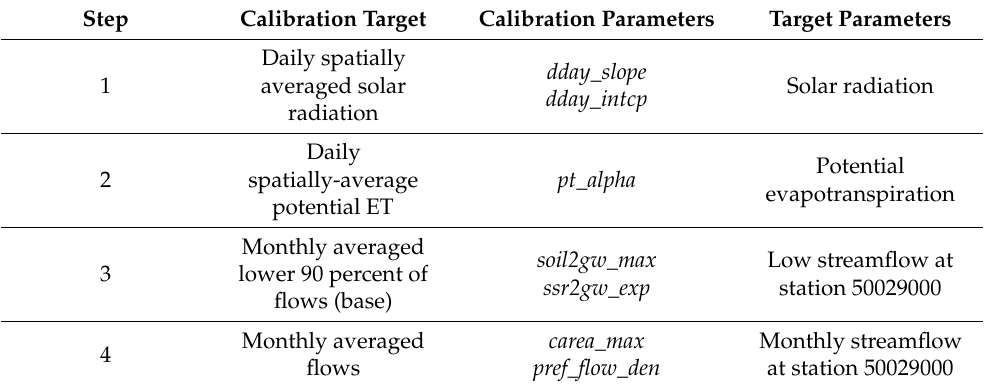
Table 5. Details of four-step Luca calibration